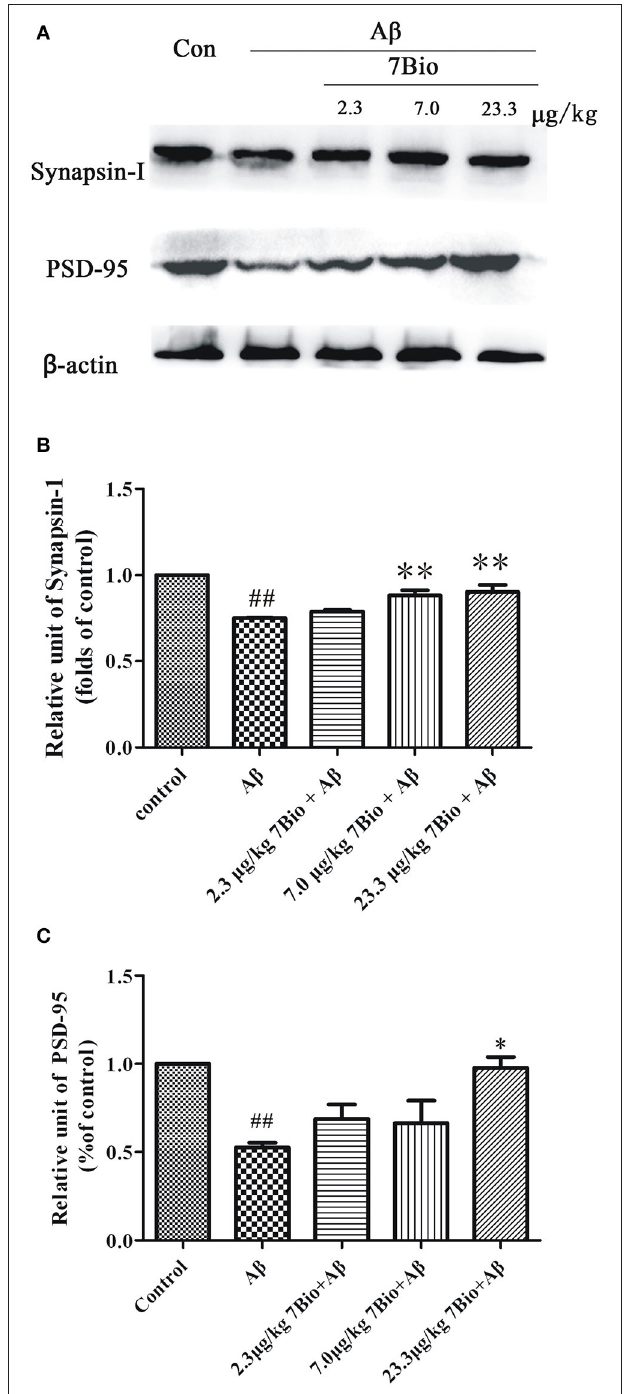
FIGURE 8 | 7Bio attenuates A β oligomer-induced decrease expression of synapsin-1 and PSD-95 in mice. At day 19 post-surgery, mice were sacrificed. (A) The expressions of synapsin-1, PSD-95 and β -actin were evaluated by Western blotting analysis. The quantitative analysis of levels of synapsin-1 and PSD-95 were shown in (B) and (C) , respectively. Data represent the mean ± SD ( n = 4); ## p < 0.01 vs. control group, * p < 0.05 and ** p < 0.01 vs. A β group (one-way ANOVA and Tukey’s